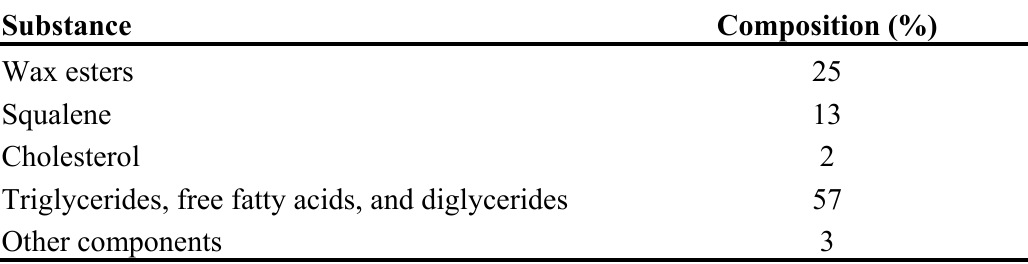
Table 1. Composition of sebum in